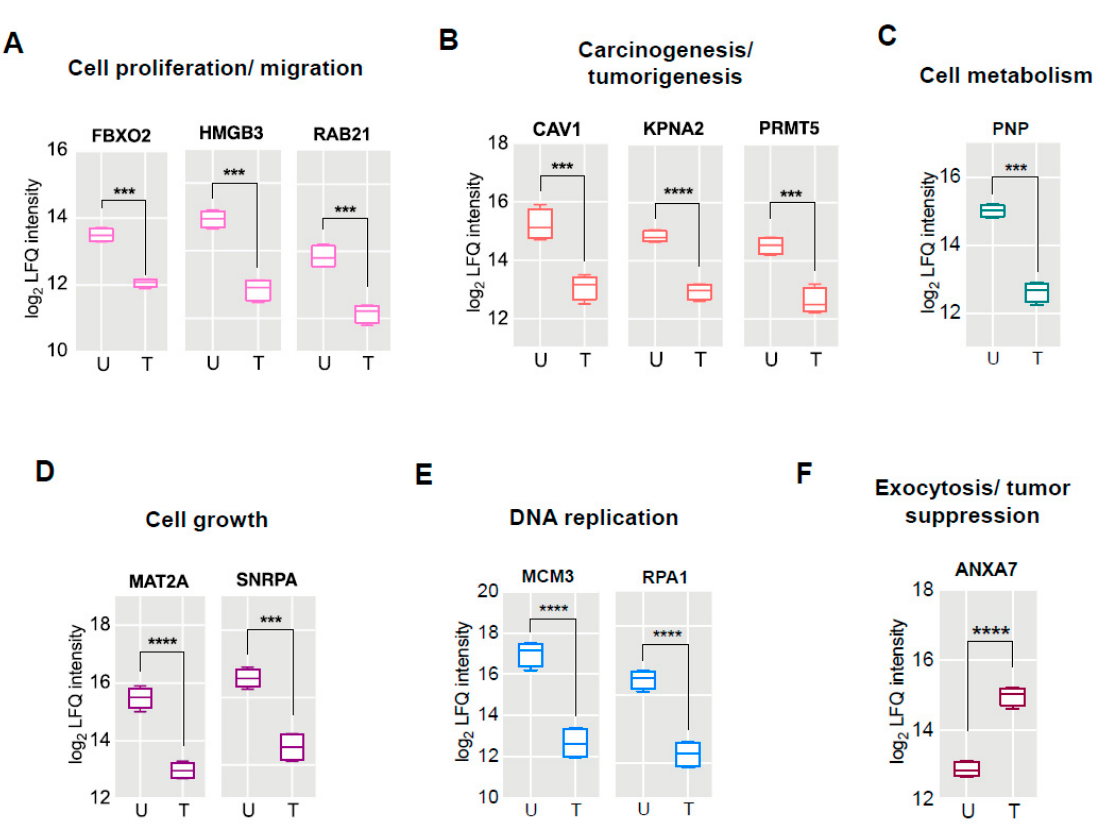
Figure 4. Proteomic signatures of GS treated HCT 116 cells. Box plots representing the differential expression of proteins based on abundance (LFQ intensity) in untreated and treated samples categorized based on their functional roles ( A ) cell proliferation/ migration, ( B ) carcinogenesis/ tumorigenesis, ( C ) cell metabolism, ( D ) cell growth, ( E ) DNA replication, and ( F ) exocytosis/ tumor suppression. U: untreated, T: GS treated. *** p < 0.002; **** p < 0.0001.